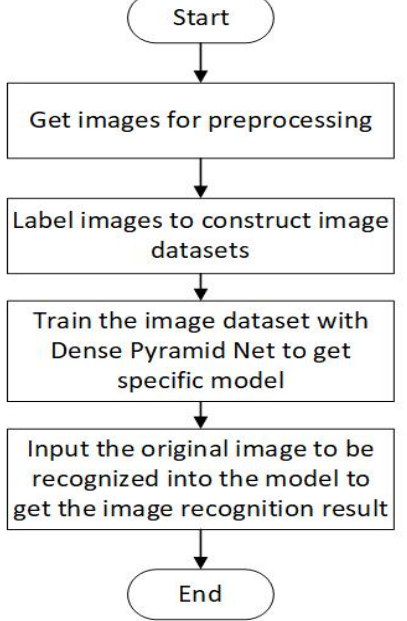
Figure 6. The flow of the proposed image recognition method.